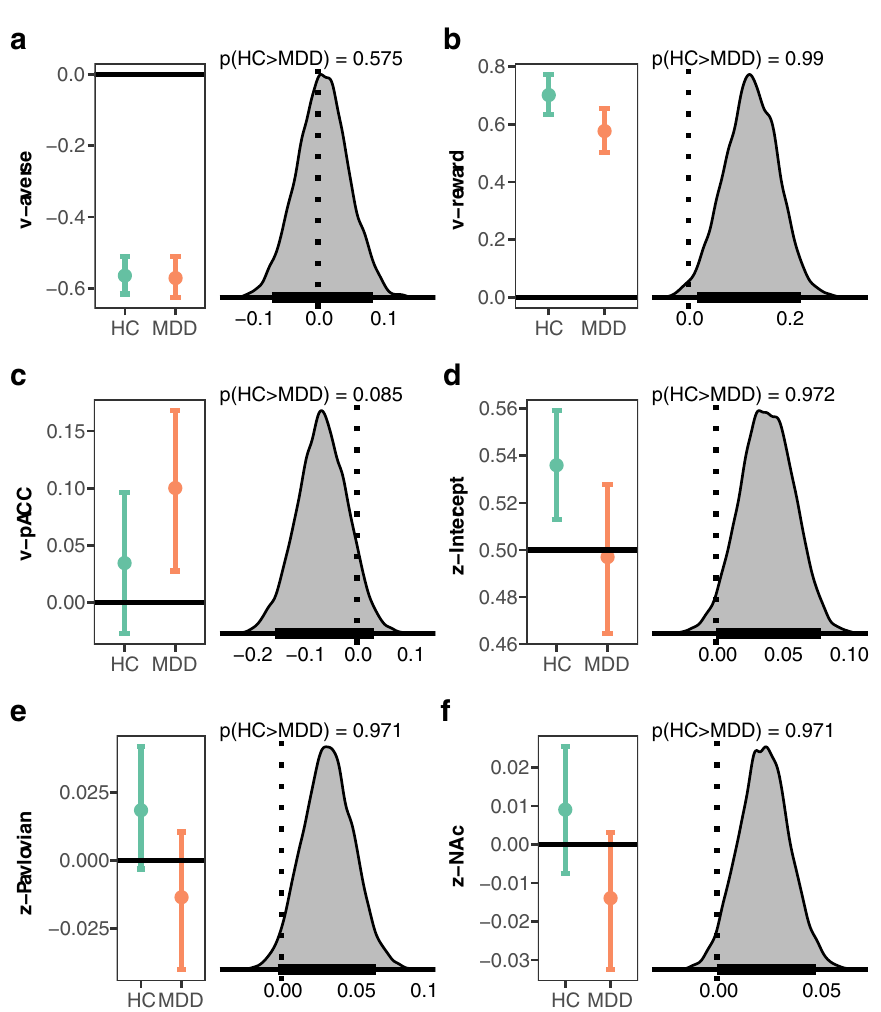
Fig 3. Selected results from the computational model. For each coefficient the left plot shows the group posterior distribution for healthy controls (HC) and individuals with major depressive disorder (MDD). The right plot shows the posterior distribution of difference as a measure of the effect of group on each coefficient, and the probability given data that the coefficient is higher in HC than MDD. a , weight of aversiveness onto drift rate (v), b , weight of reward onto drift rate (v), c , estimated relative starting point (z) between decision thresholds, d , impact of Pavlovian effect onto starting point (z), e , impact of activity in nucleus accumbens (NAcc) onto starting point (z), f , impact of activity in the pACC onto drift rate (v). For the entire set of coefficients see Table